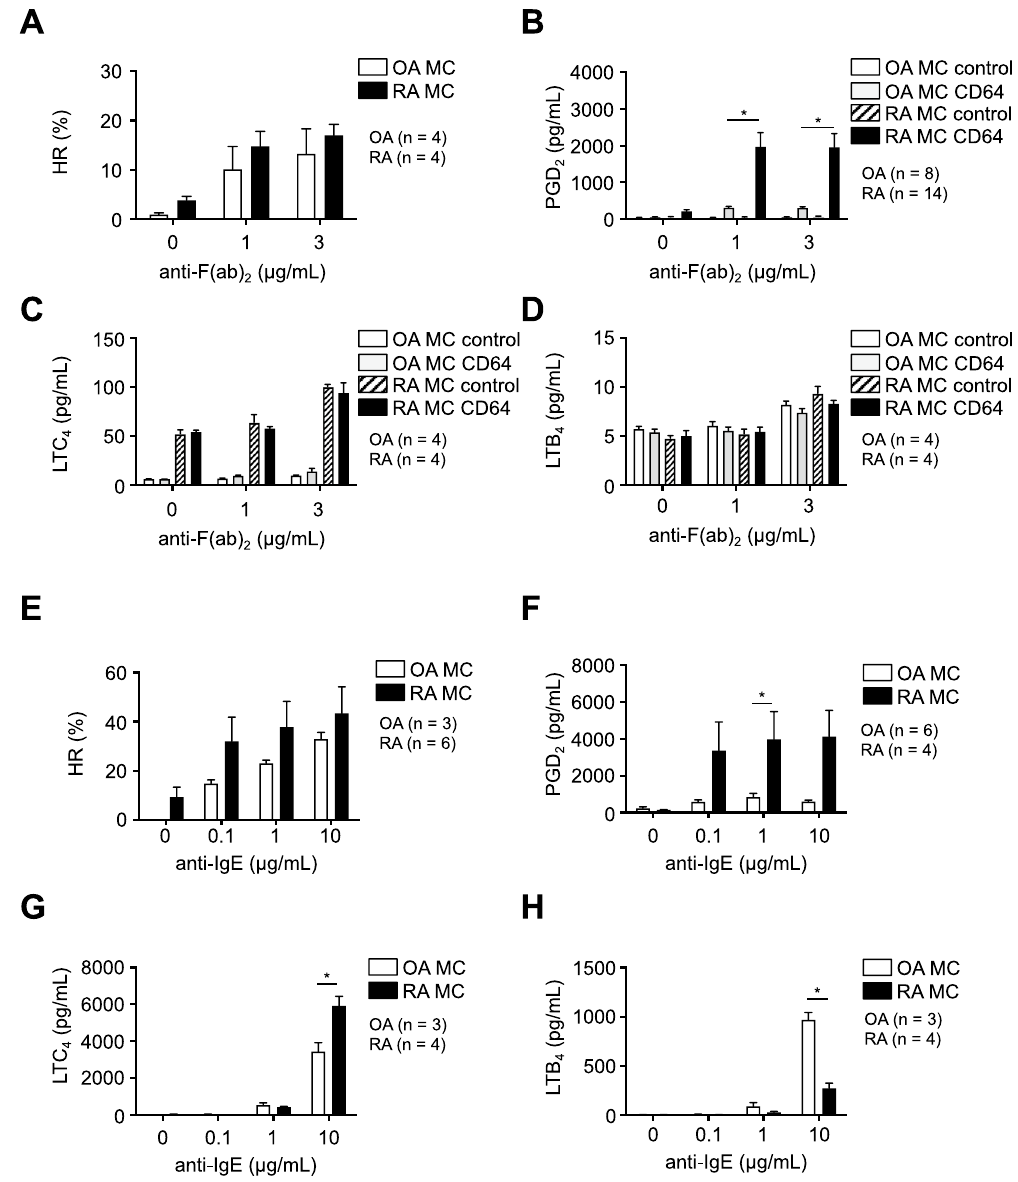
Figure 2. Comparison of histamine release ( A , E ) and PGD 2 ( B , F ), LTC 4 ( C , G ) and LTB 4 synthesis ( D , H ) by synovium-derived, cultured MCs obtained from OA and RA patients following FcγRI aggregation ( A – D ) and FcεRI aggregation ( E – H ). Data are shown as % HR (histamine release) or pg/mL (/10 5 cells, mean ± SEM). Significance was determined by Sidak’s-Bonferroni test (* P <